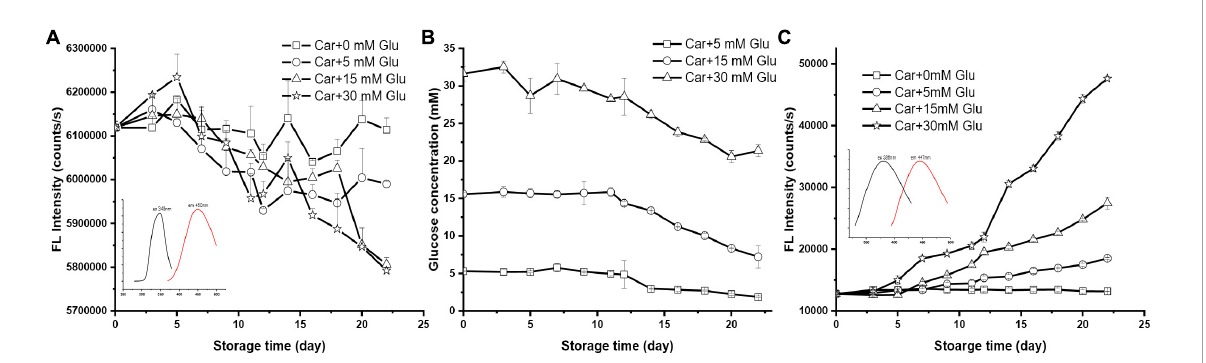
FIGURE1 The changes of (A) carnosine florescence intensity, (B) glucose concentration, and (C) the formation of MRP during storage (the initial mixture contained 10 mM carnosine with 0, 5, 15, or 30 mM of glucose; inserted EX/EM scan was OPA derivatized carnosine and